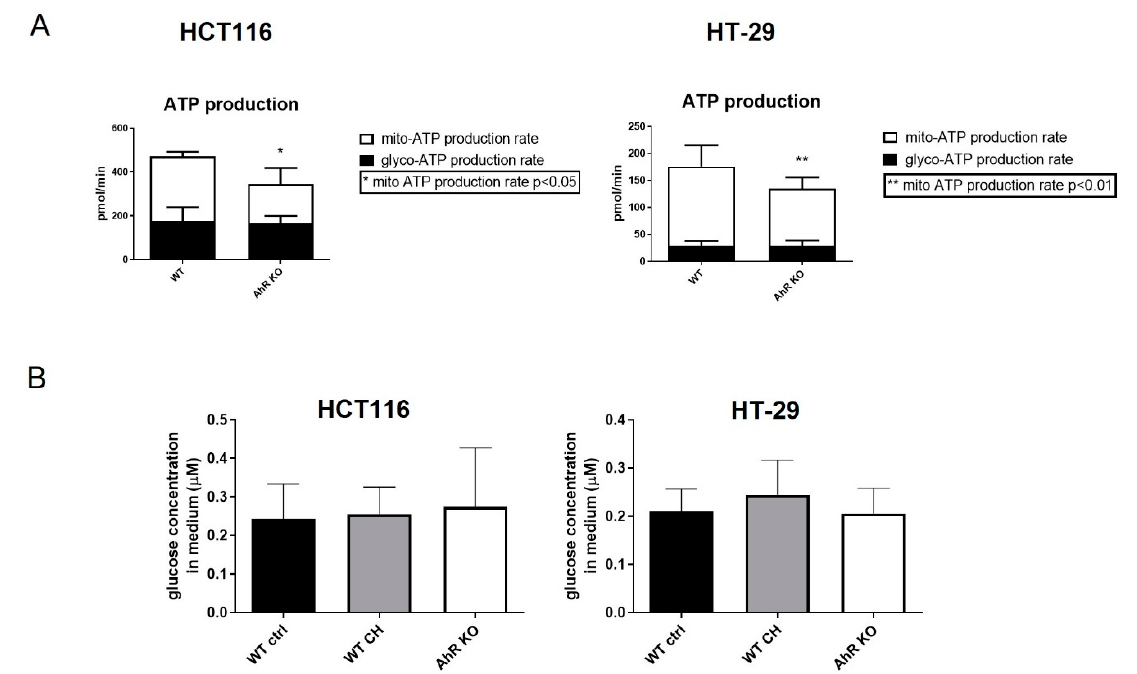
Figure 4. AhR deficiency alters ATP production rate in HCT116 and HT-29 cells. ( A ) Real-time ATP production rate was measured by SeaHorse XFp, and the contribution of mitochondria-produced ATP (mito-ATP) and glycolysis-produced ATP (glyco-ATP) to total ATP levels was determined. The data are shown as means + SD of three independent experiments. * and ** denote a significant difference ( p < 0.05 and p < 0.01, respectively) between AhR KO and wild-type cells. ( B ) Glucose uptake was measured by colorimetric assay determining the concentration of glucose in cell culture medium collected from cells after 48 h of cultivation. The effect of AhR KO was compared with that of incubation of cells with the AhR antagonist CH-223191 (10 μ M).